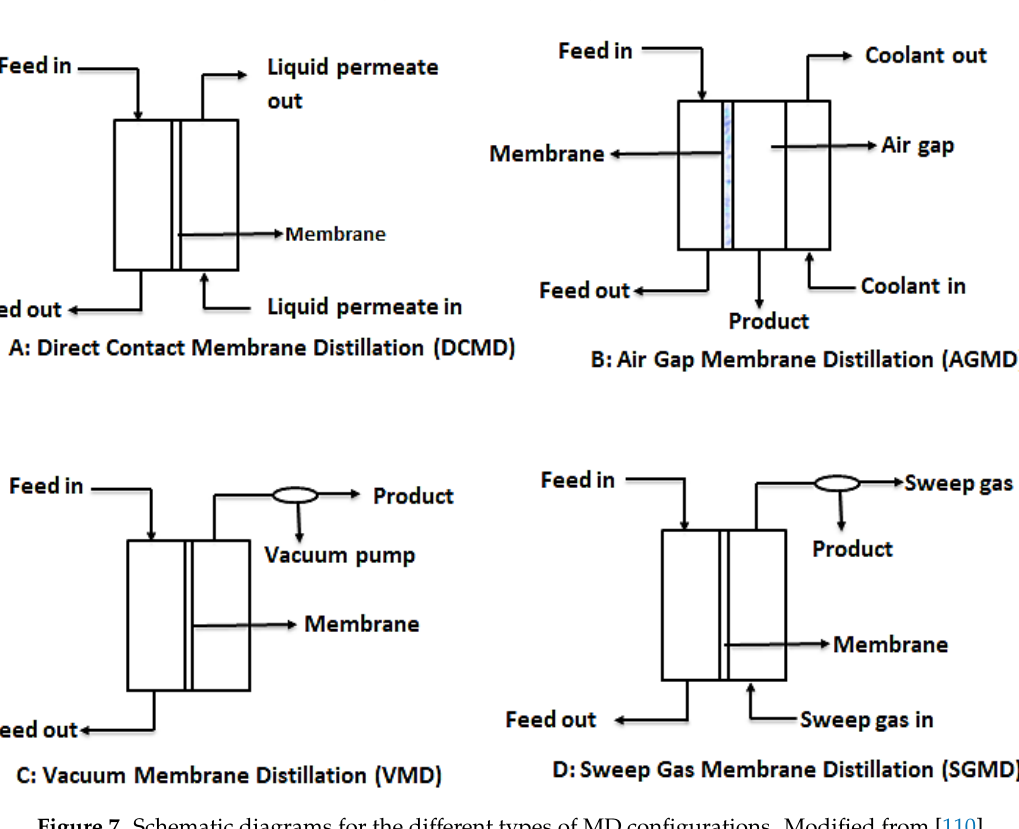
Figure 7. Schematic diagrams for the di ff erent types of MD configurations. Modified from [110] .